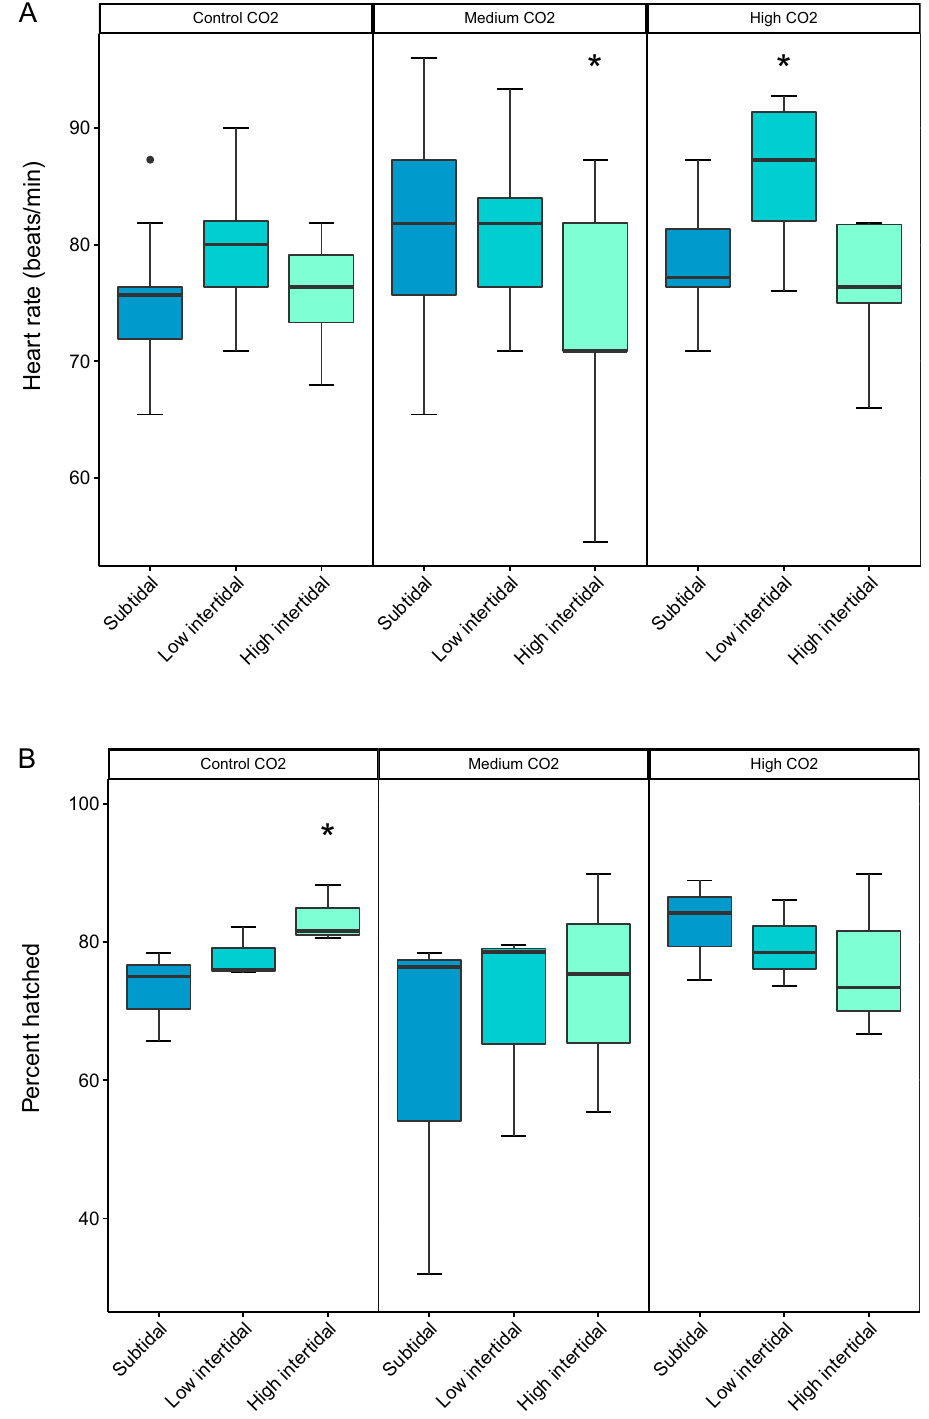
Figure 4. Embryonic heart rate, hatch success, length at hatch and cumulative mortality show a complex response to CO 2 and air exposure. Box-whisker plots showing the 25th and 75th percentile (box), the median (line), the 0 and 100th percentile (whiskers) and outliers (points) of ( A ) Embryonic heart rate, ( B ) hatch success, ( C ) length at hatch and ( D ) percent cumulative mortality to 6 dph; for three tidal regimes (subtidal = no air exposure; low intertidal = 2 × 2 h air exposure day −1 ; high intertidal = 5 + 9 h air exposure day −1 ) at three different aquatic CO 2 rearing conditions (Control = 400µatm; Medium = 1600µatm; High = 3000 µatm CO 2 ). Stars above box-whisker plots denote significant differences relative to the subtidal (fully immersed treatment) at the respective CO 2 level (effect size statistics in Table